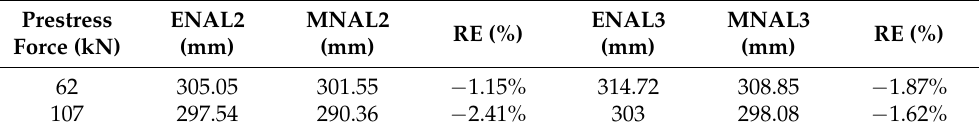
Table 5. Comparison of the neutral axis locations between the experimental and numerical results.